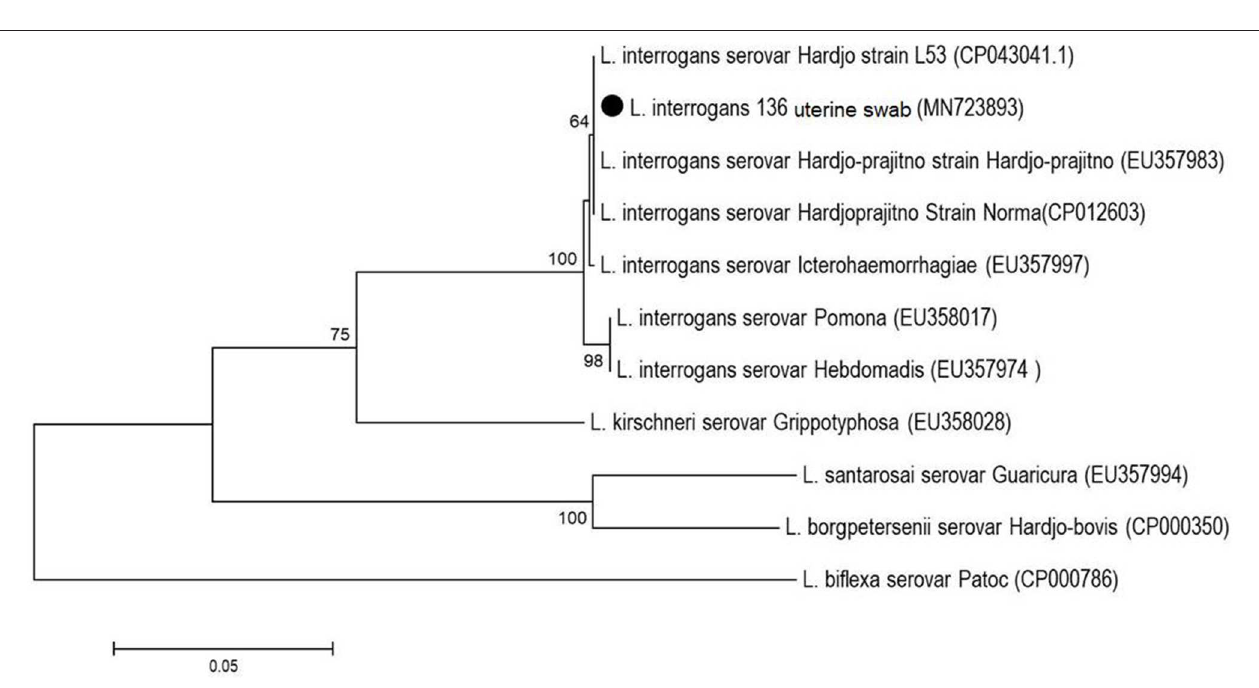
FIGURE 3 | Phylogenetic analysis based on partial secY gene of Leptospira spp. from the uterine swab sample (black circle). The tree was elaborated with Neighbor-Joining method and Tamura-3 parameter model with bootstrap test of 1,000 replicates.